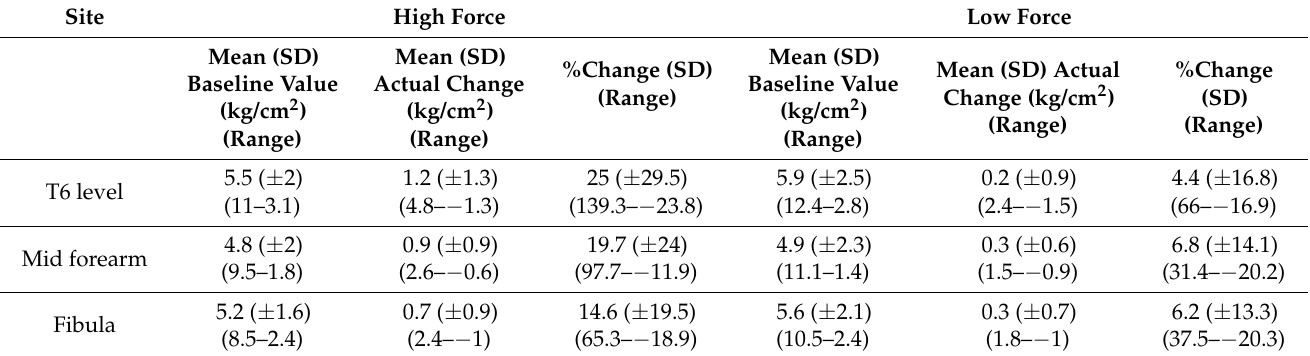
Figure 8. Actual change in PPTs. Table 4. Mean baseline values, mean increase and percentage change (%) of PPT in each experimental condition. SD = Standard deviation.